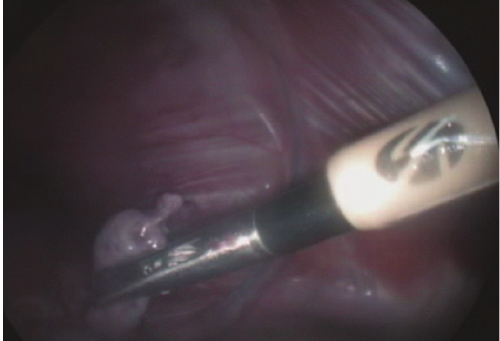
Figure 4: Grasping the retrieved cryptorchid testis for removal and external ligation via an enlarged 5 mm port site